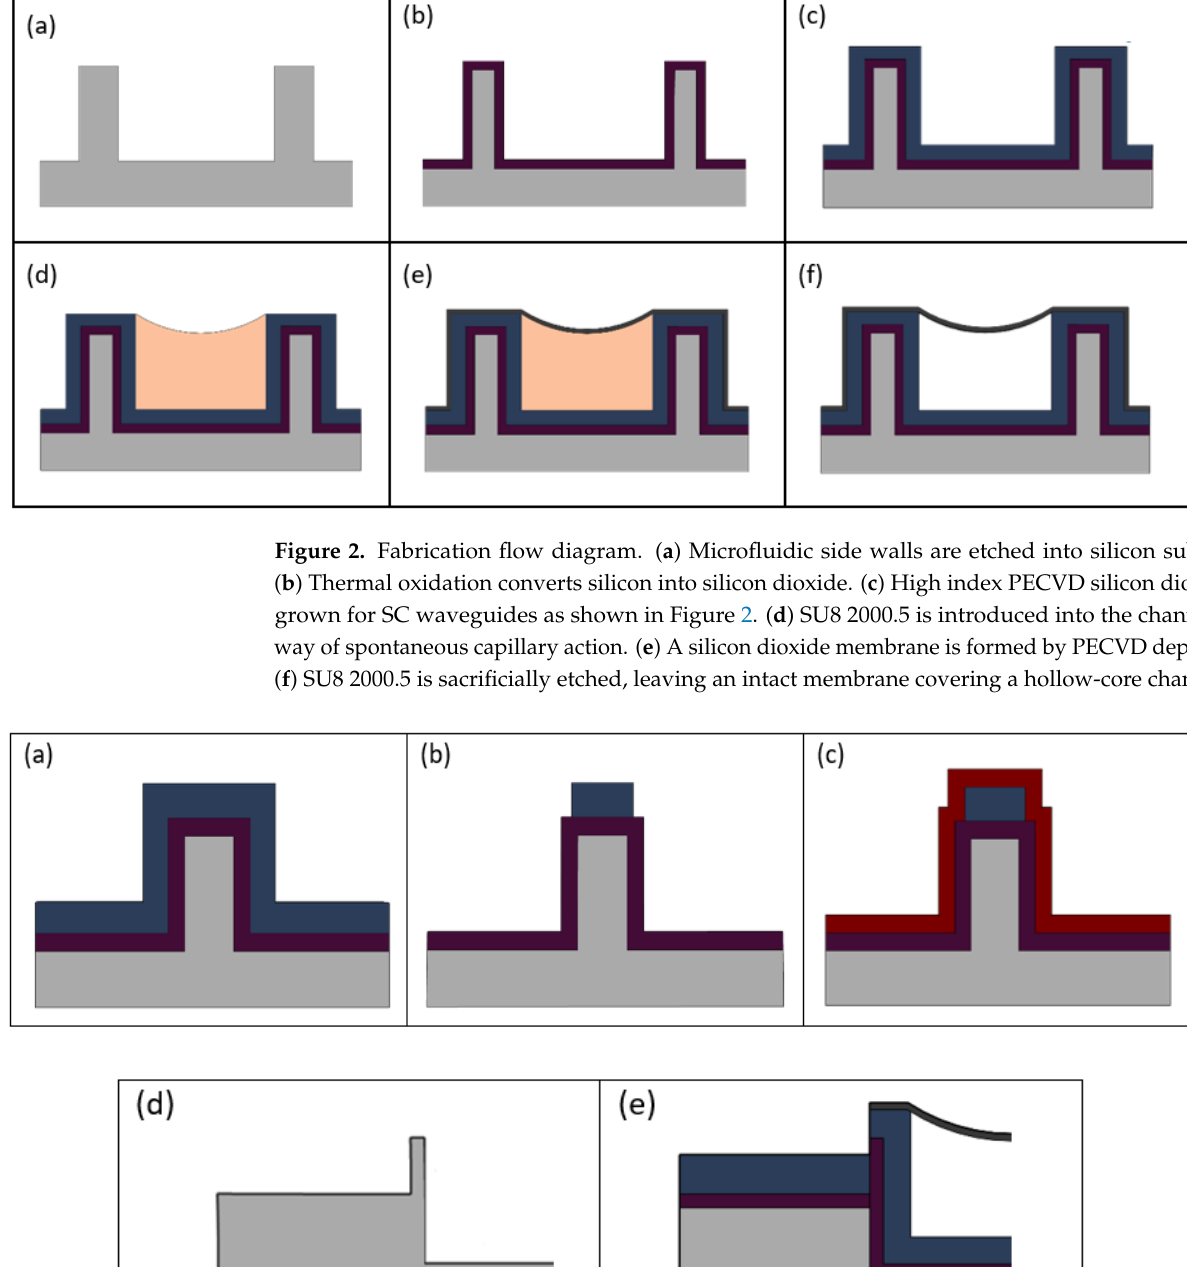
3 of 14 Figure 1. Scanning electron micrograph (SEM) of a solid-state pore drilled into a nanomembrane on an optical manipulation device using a focused ion beam (FIB). 2. Nanofabrication Process Figure 2 depicts the method used to fabricate the optofluidic particle manipulator. The microfluidic design is first patterned on a 100 mm silicon wafer by way of photoli- thography utilizing AZ Nlof 2020 photoresist. The features of note include 3 mm long microfluidic channels attached to inlet and outlet openings, reservoir walls, and an opto-